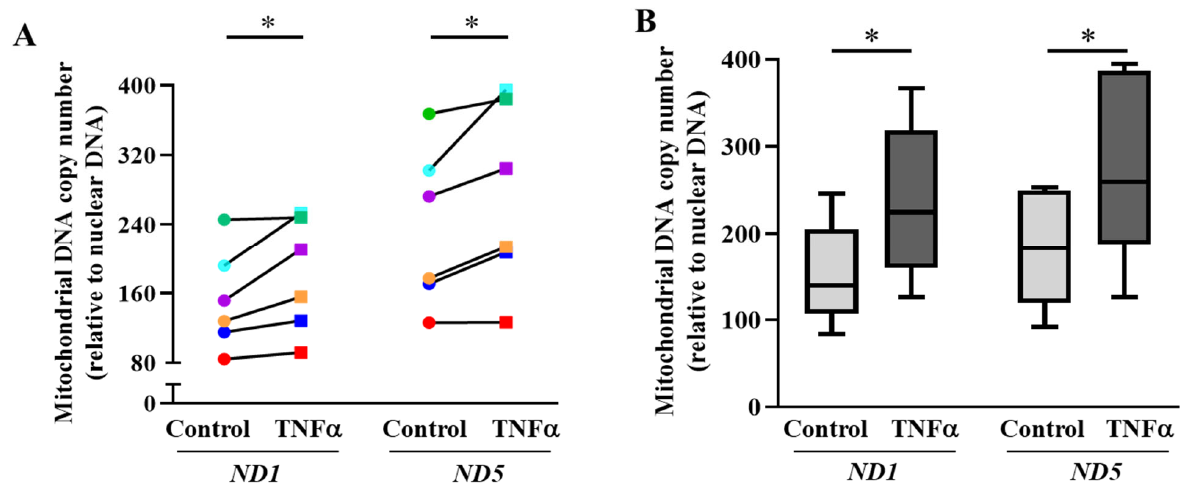
Figure 4. TNF α increases mitochondrial DNA copy number in hASM cells. ( A ). Mitochondrial DNA copy number was quantified using mitochondrial DNA specific primer sets (both ND1 and ND5 ) via qPCR and represented as a fold change relative to nuclear DNA ( SLCO2B1 and SERPINA1 ). Both mtDNA copy numbers ( ND1 and ND5 ) were compared between TNF α -treated (20 ng/mL for 6 h) (squares) and untreated (circles) hASM cells for each of six patient hASM samples (represented by different colors). Note that in each patient, relative DNA copy numbers ( ND1 and ND5 ) increased in hASM cells exposed to TNF α (20 ng/mL for 6 h) (* p < 0.05; n = 6). ( B ). The mtDNA copy number results were summarized as box-whisker plots showing the median and minimum to maximum distribution of ND1 and ND5 relative mtDNA copy number across the six patient samples. Statistical analyses on measures of mtDNA copy number were performed on n = 6 patient hASM samples using a paired t ‐ test (* p < 0.05).